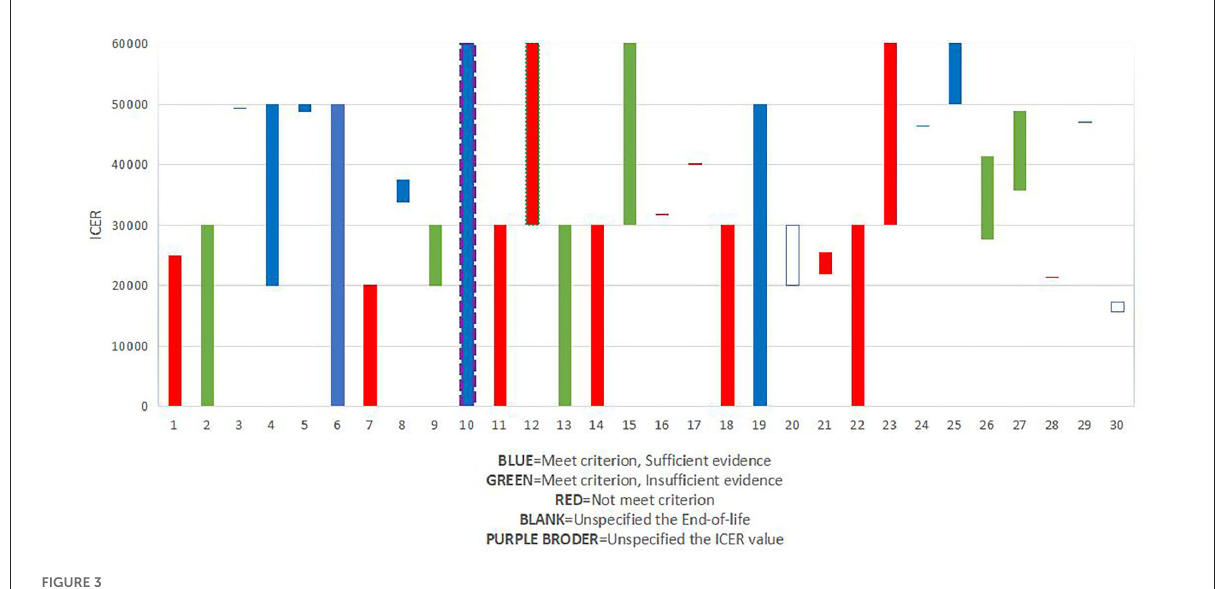
FIGURE3 Relationship between end of life and ICER of orphan oncology